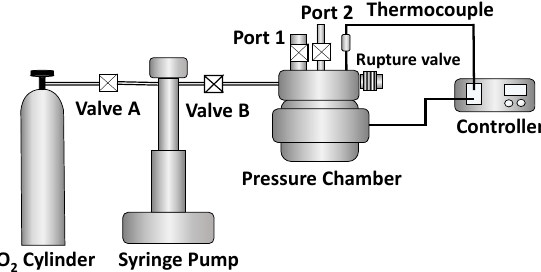
Figure 6. Schematic of the custom-built batch foaming system used to prepare foams of the samples in a process using CO 2 as the foam blowing agent.